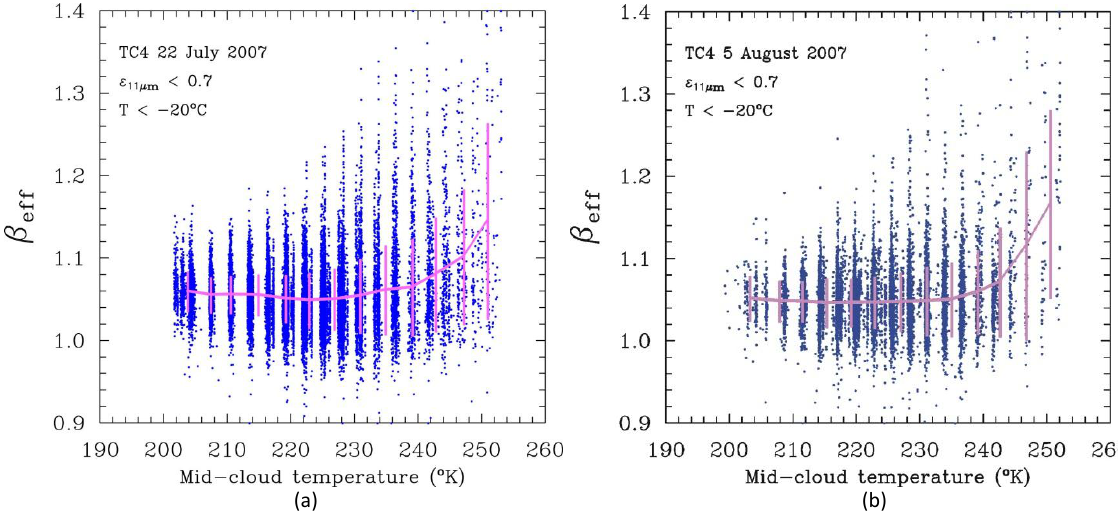
Fig. 5. Retrievals of the effective absorption optical thickness ratio related to retrieved mid-cloud temperature for (a) the 22 July cloud scene and (b) the 5 August cloud scene. Cloudy pixels were filtered so that only pixels having 11µm emissivities less than 0.7 and temperatures less than − 20 ◦ C were used.